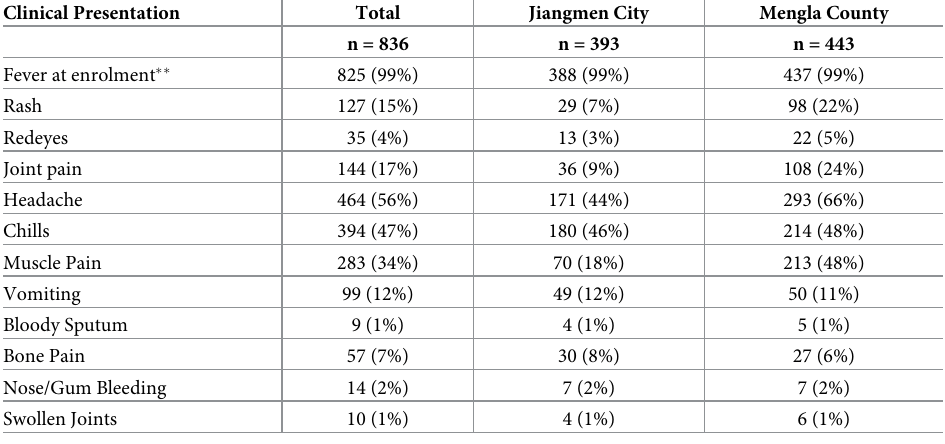
� Of the 836 AFI patients, 641 (77%) were hospitalized at the time of enrollment; 303 (77%) in Jiangmen City. and 338 (76%) in Mengla County. The remaining 195 (23%) patients were enrolled as outpatients. �� Eleven (1%) patients were eligible based on reported history of fever within the last 7